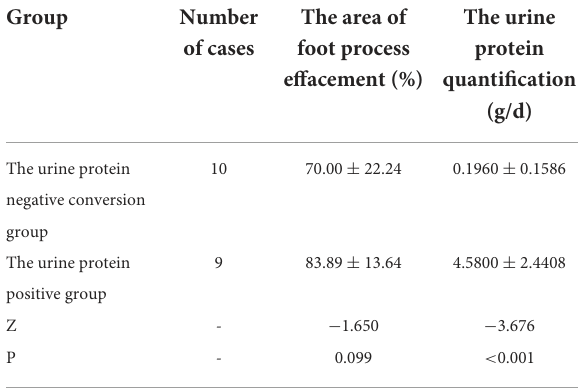
TABLE 3 The comparison of the area of foot process effacement and urine protein quantification between the urine protein negative conversion group and the urine protein positive